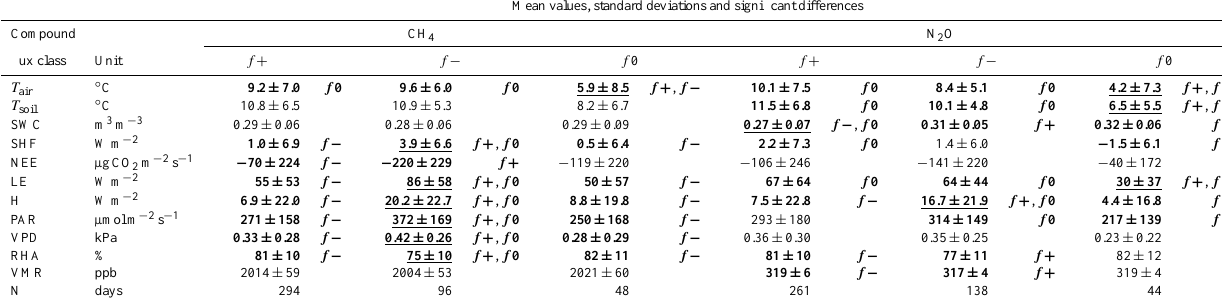
Table 2. Daily average means in three different groups of daily net CH 4 (N 2 O) exchange. Significant differences between group means were determined in a repeated measures ANOVA setting, using the unequal n HSD post hoc test. Group labels to the right of a given group mean show to which flux group the respective value was significantly different. Bold numbers mark group means that were significantly different from one other group, while bold underlined numbers denote group means that were significantly different from both other groups. f +